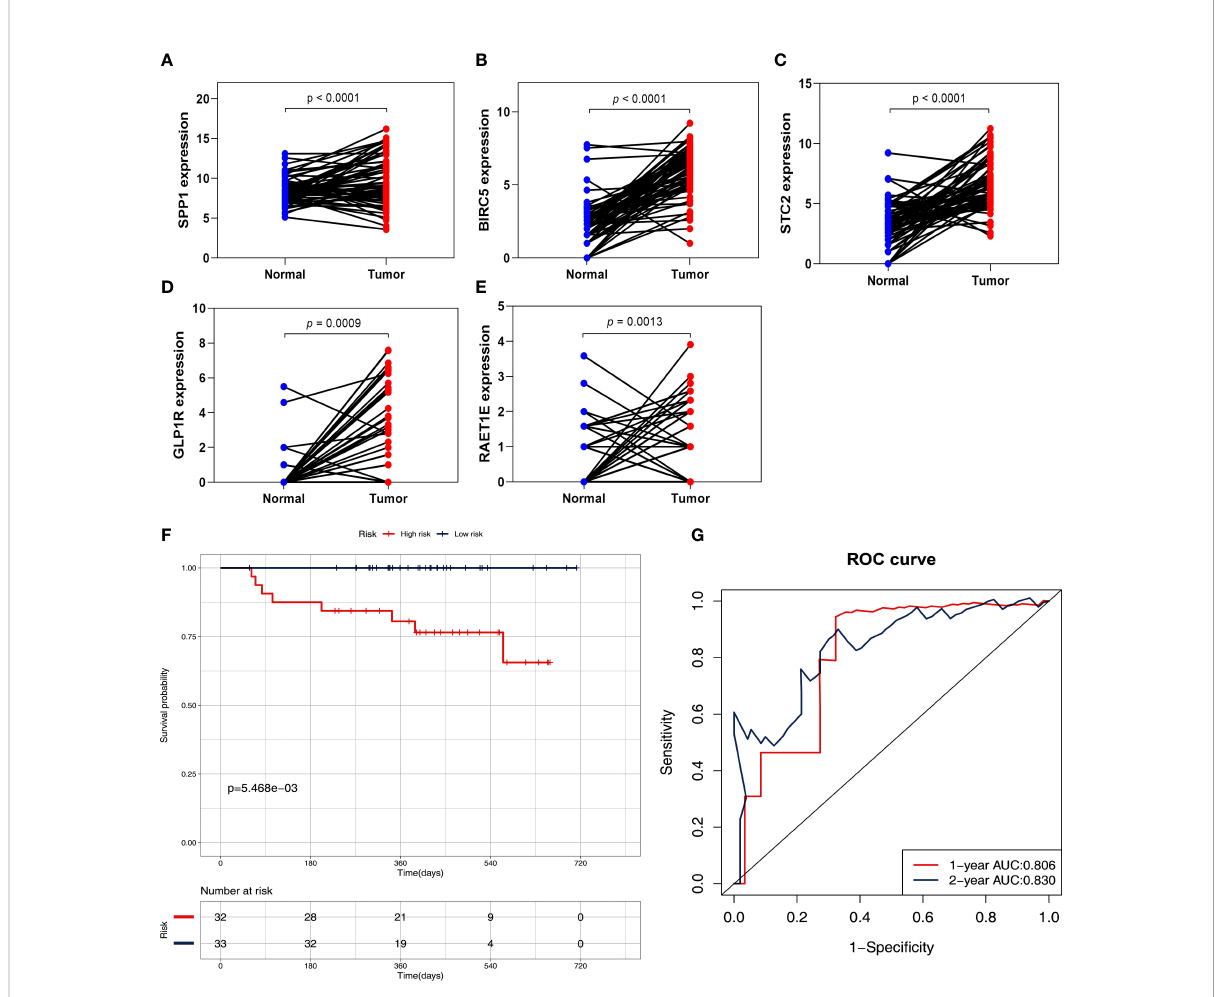
FIGURE 9 Validation of fi ve IRGs mRNA expression by RNA sequencing in 65 HCC patients. (A) the expression of SPP1. (B) the expression of BIRC5. (C) the expression of STC2. (D) the expression of GLP1R. (E) the expression of ARET1E. (F) Survival curves for the low risk and high-risk groups. (G) Time-independent ROC analysis of risk scores for prediction the